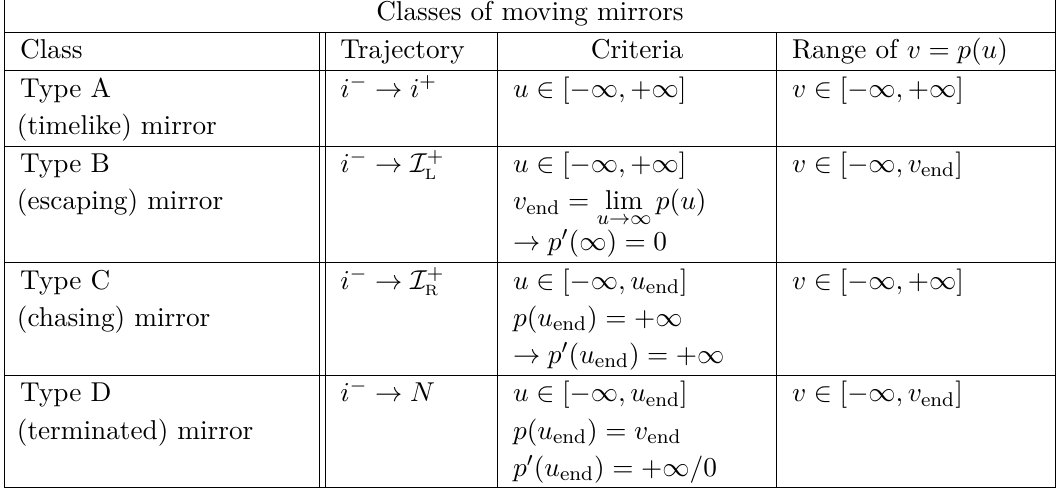
Table 1 . An overview of key features related to moving mirrors of four distinct types.